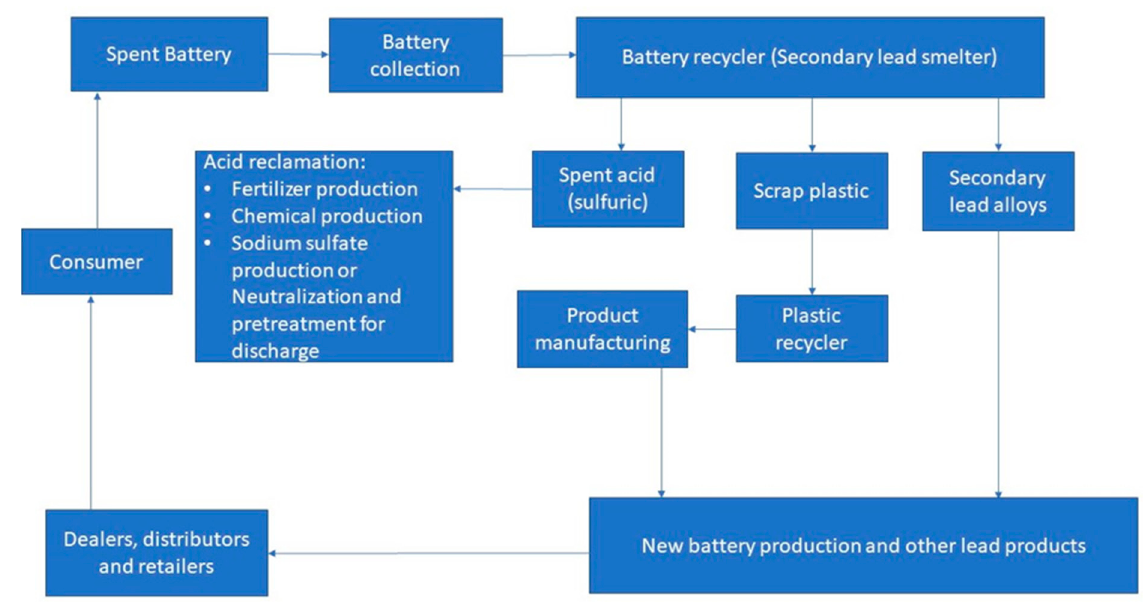
Figure 10. A systematic representation of the lead-acid battery process [102].